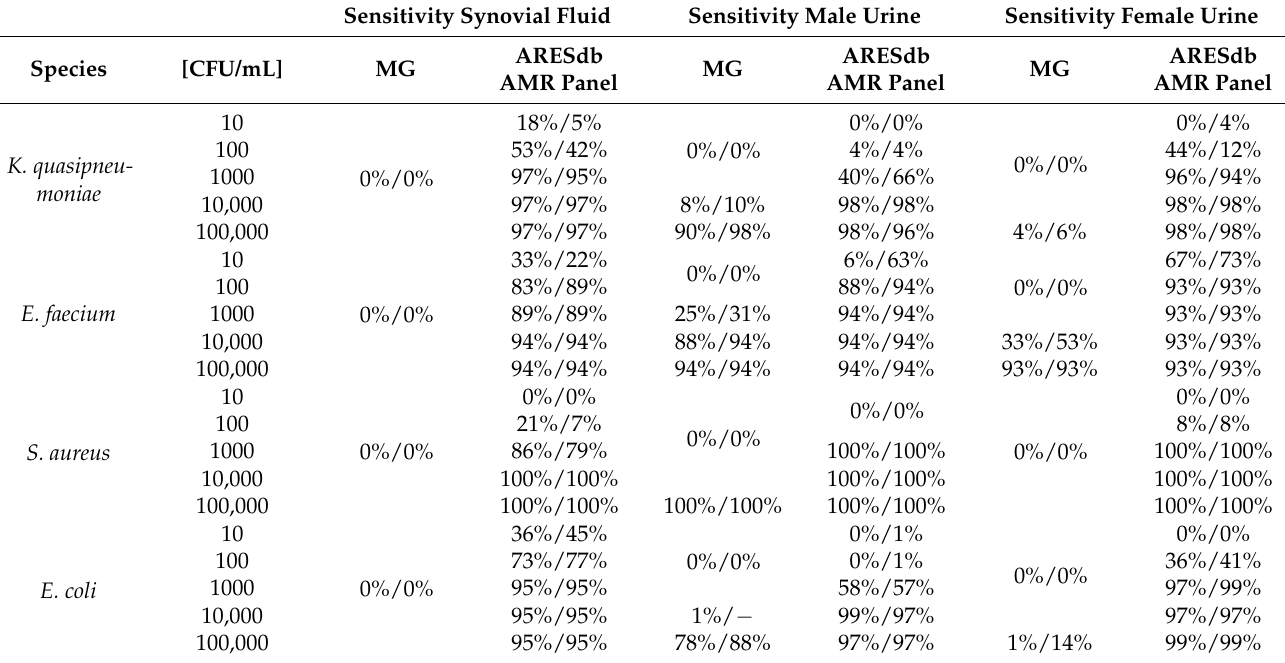
Table 2. Sensitivity of the ARESdb AMR panel versus metagenomics sequencing for spiked-in native materials. Sensitivity Synovial Fluid Sensitivity Male Urine Sensitivity Female